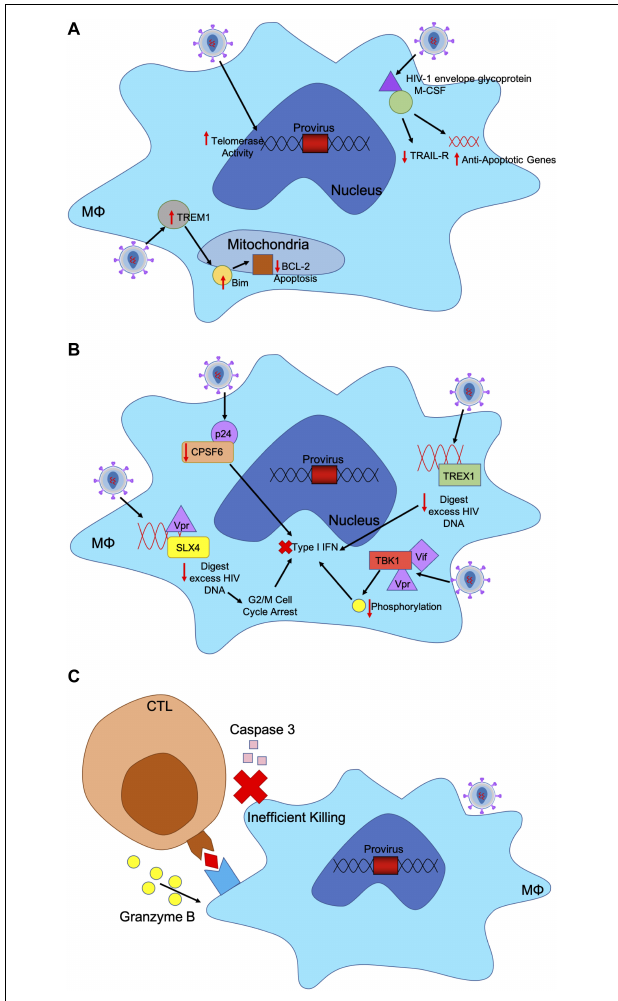
FIGURE 2 | HIV-1 has evolved mechanism to evade host immune responses in macrophages. (A) HIV-1 infected macrophages are refractory to the cytopathic effects of viral infection. Infected cells usually undergo apoptosis or cell-mediated killing upon viral infection. HIV-1 upregulates certain factors to evade apoptosis. HIV-1 envelope glycoprotein binds to M-CSF to downregulate TRAIL-receptor and upregulate anti-apoptotic genes. HIV-infected macrophages express higher levels of TREM1, which upregulates and translocates Bim to the mitochondria to downregulate BCL-2 induced apoptosis. Additionally, HIV-infected macrophages have increased telomerase activity, triggering less DNA damage and sustained infection. (B) HIV-1 induces mechanisms to evade IFN responses in infected macrophages through accessory proteins. TREX1 binds to excess HIV DNA during reverse transcription to suppress IFN responses. HIV-1 capsid binds to and removes CPSF6 and cyclophilins to silence downstream innate sensors of IFN pathways. HIV-1 Vif and Vpr bind to TBK1, preventing phosphorylation and downstream IFN induction. HIV-1 Vpr also binds to SLX4 complex with reverse transcribed HIV-1 DNA, like TREX1 to degrade nucleic acids and increase cellular replication stress, leading to G2/M cell cycle arrest and prevent IFN response. (C) CTLs recognize peptide antigens presented by MHC-I and release cytotoxic particles to kill infected cells. HIV-1 infected macrophages are resistant to CTL killing as CTLs require both granzyme B and caspase-3 to efficiently kill HIV-1 infected macrophages unlike CD4+ T cells which only need granzyme B. CTL binding to MHC-I only triggers release of granzyme B, which renders a much slower and less efficient killing of